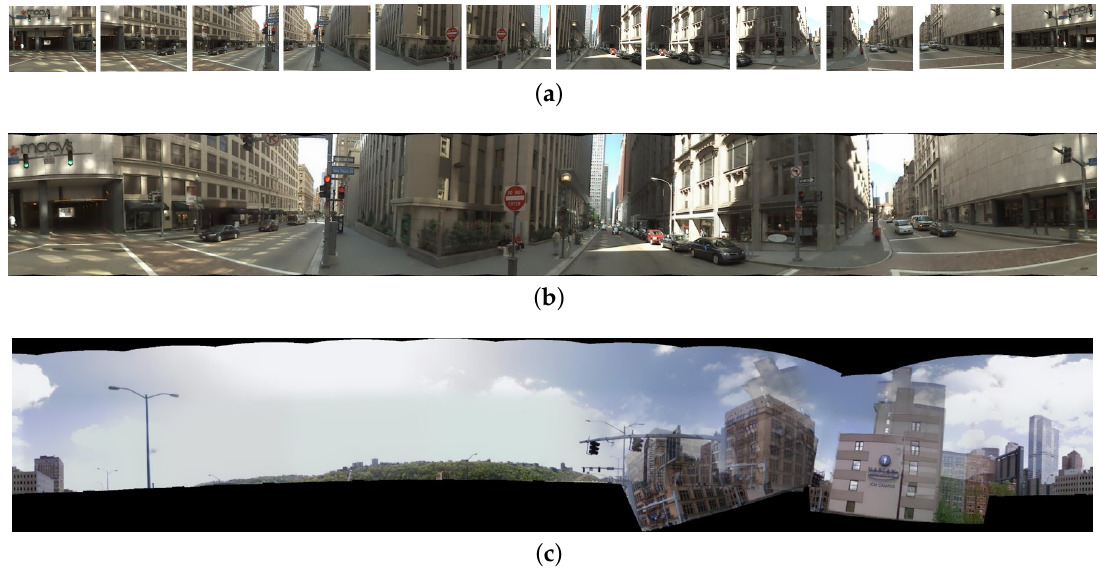
Figure 7. ( a ) random bottom 12 images in one location from Pittsburgh dataset; ( b ) the stitched panorama of ( a ); ( c ) a mis-stitched